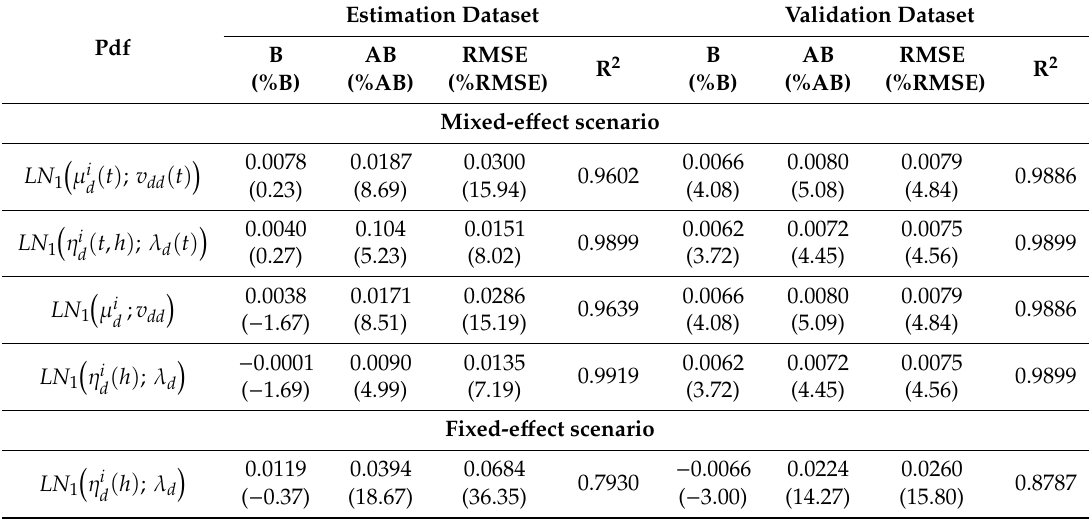
Table 12. Statistical measures for all fitted basal, BA, area (m 2 ) models.